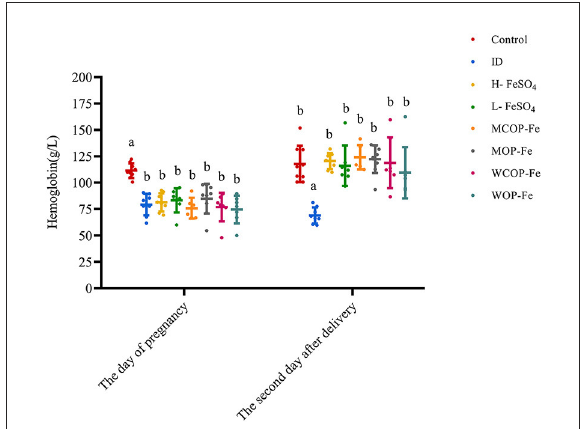
FIGURE2 Hemoglobin in rats before and after intervention. Data are presented as mean ± SD, P < 0.05 is regarded as significant level, and values marked with different letters show significant differences. One-way ANOVA followed by LSD analyses was used for comparison among 8 different groups. ID, iron deficiency anemia model group (4 ppm FeSO 4 ); H-FeSO 4 , 400 ppm FeSO 4 ; L-FeSO 4 , 40 ppm FeSO 4 ; MCOP-Fe, 400 ppm marine fish oligopeptide iron complex; MOP-Fe, 40 ppm marine fish oligopeptide iron complex; WCOP-Fe, 400 ppm whey protein oligopeptide iron complex; WOP-Fe, 40 ppm whey protein oligopeptide iron